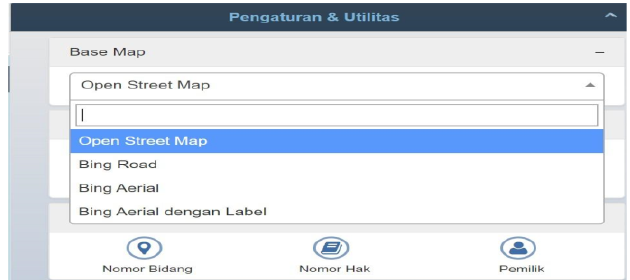
Figure 5. Spatial cadastre map in the KKP application used by the land office of North Jakarta city administration.